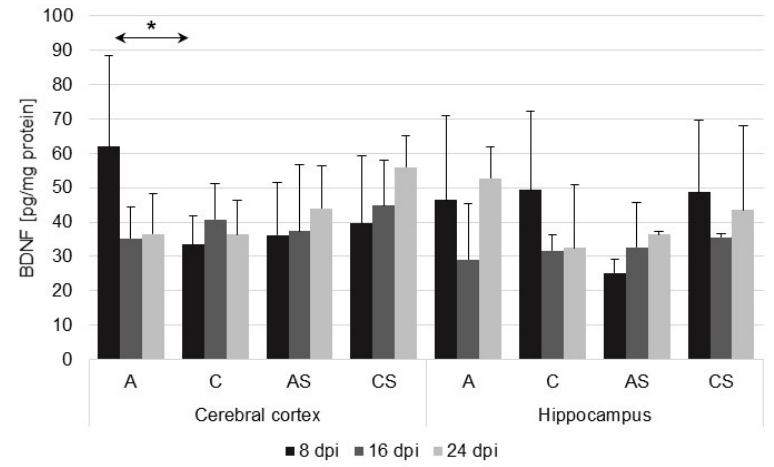
Figure 1. Brain-derived neurotrophic factor (BDNF) level (pg/mg protein) in the cerebral cortex and hippocampus in control and infected groups at 8, 16, and 24 days after Acanthamoeba spp. infection (dpi). Data present means ± SD for 6 independent experiments. C, immunocompetent uninfected mice; CS, immunosuppressed uninfected mice; A, immunocompetent Acanthamoeba spp. infected mice; AS, immunosuppressed Acanthamoeba spp. infected mice; solid arrows indicate differences between infected and control mice; * p ≤ 0.05 for the significance of difference (Mann–Whitney U test).